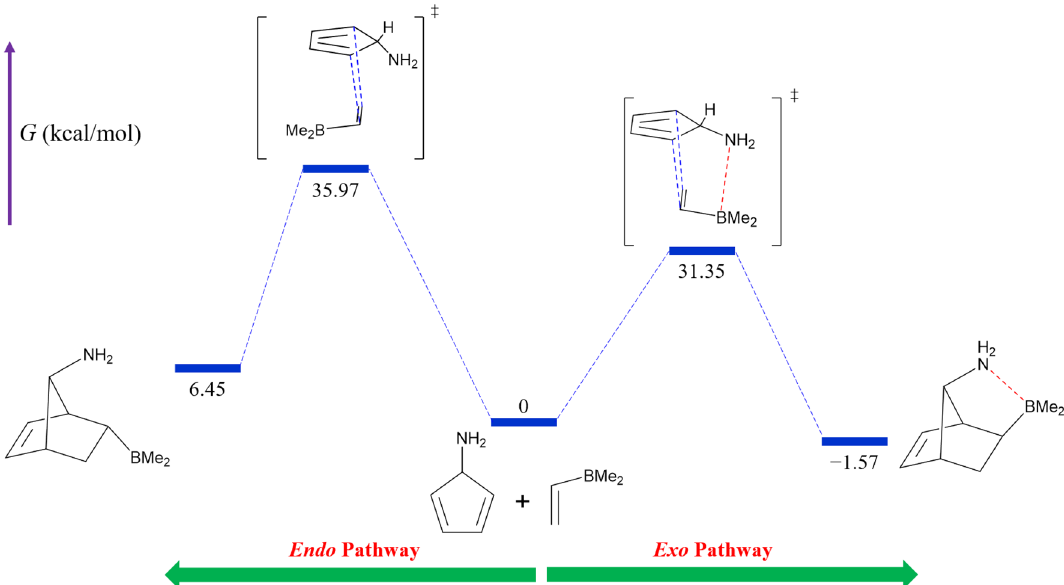
Figure 2. The reaction energy diagram for entry 1-2. Numbers represent the Gibbs free energies in kcal/mol relative to the reactants. The blue and red dashed lines represent the newly forming C–C bonds and the LAB interaction,